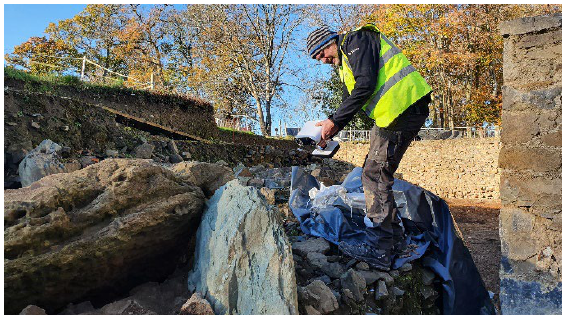
Figure 9. The Artec Leo in action at a Dowth Hall, capturing a decorated upright in the southern chamber.